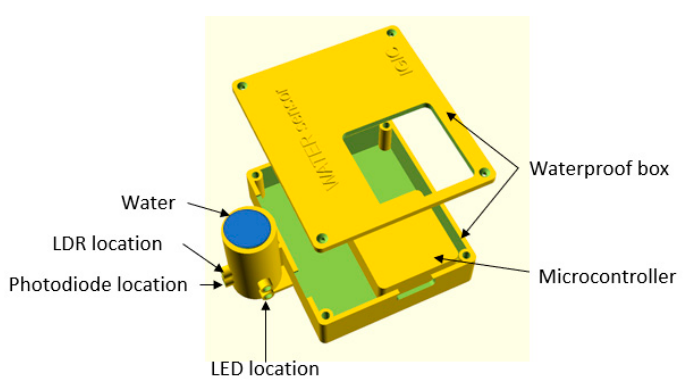
Figure 3. Scheme waterproof box.